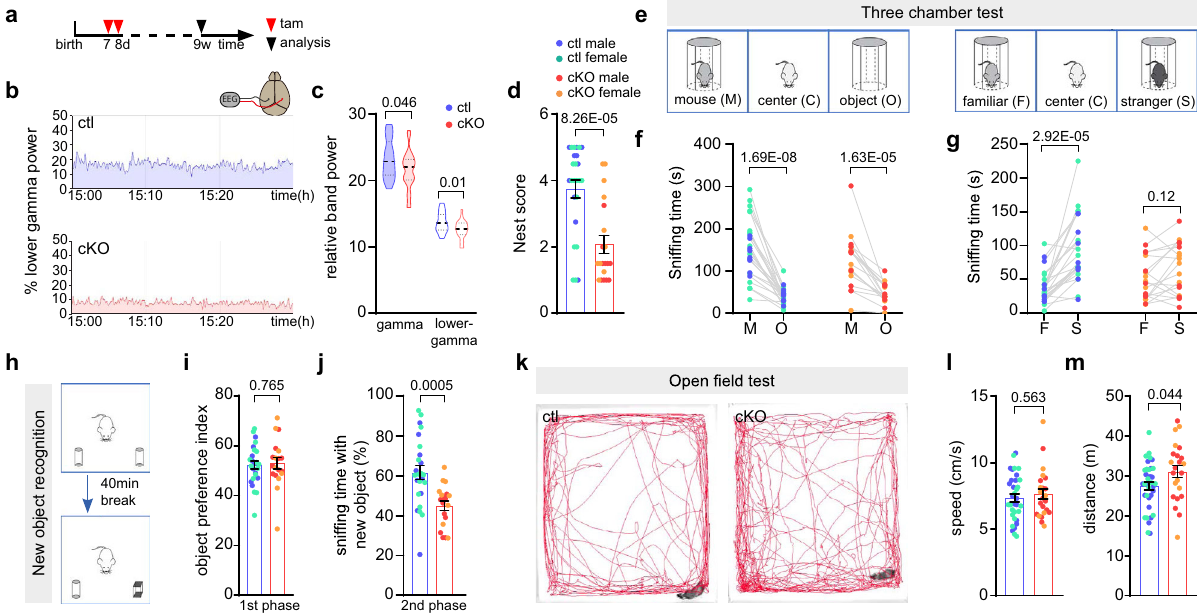
Fig. 6 In OPC-GABA B R cKO mice a perturbed neuronal fi ring translates into de fi cits of social behavior. a Experimental schedule. b Lower gamma band acquired by electroencephalogram recordings. c Violin plot shows decreased gamma oscillation in the cKO mouse brain. (ctl = 24 h from 4 mice, cKO = 24 h from 4 mice, two-sided unpaired t -tests). d Impaired nest building ability of mutant mice. (male: ctl = 10 mice, cKO = 10 mice; female: ctl = 15 mice, cKO = 10 mice, two-sided unpaired t -test). e Scheme of the three-chamber behavior test. f Quanti fi cation of the snif fi ng time with mouse (M) and object (O) (male: ctl = 9 mice, cKO = 9 mice, two-sided paired t -tests; female: ctl = 15 mice, cKO = 9 mice, two-sided paired t -tests). g Quanti fi cation